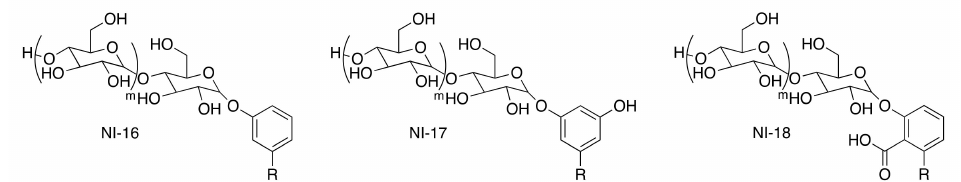
Figure 9. Amylose-based surfactants with anacardic acid, cardol or cardanol as hydrophobic tail.